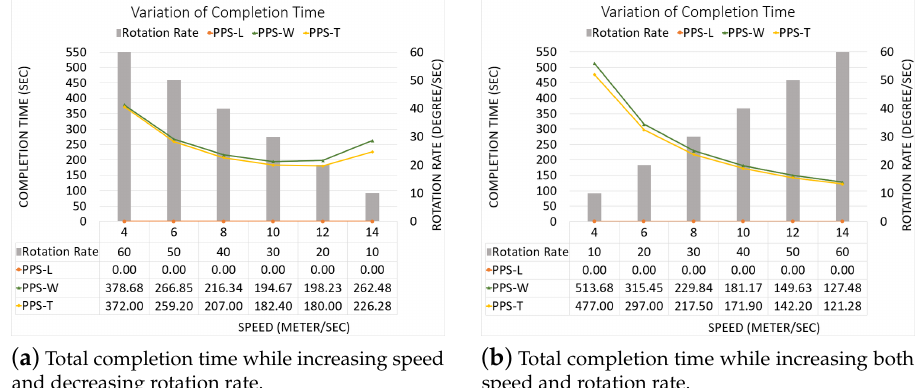
Figure 30. Gain in completion time in each